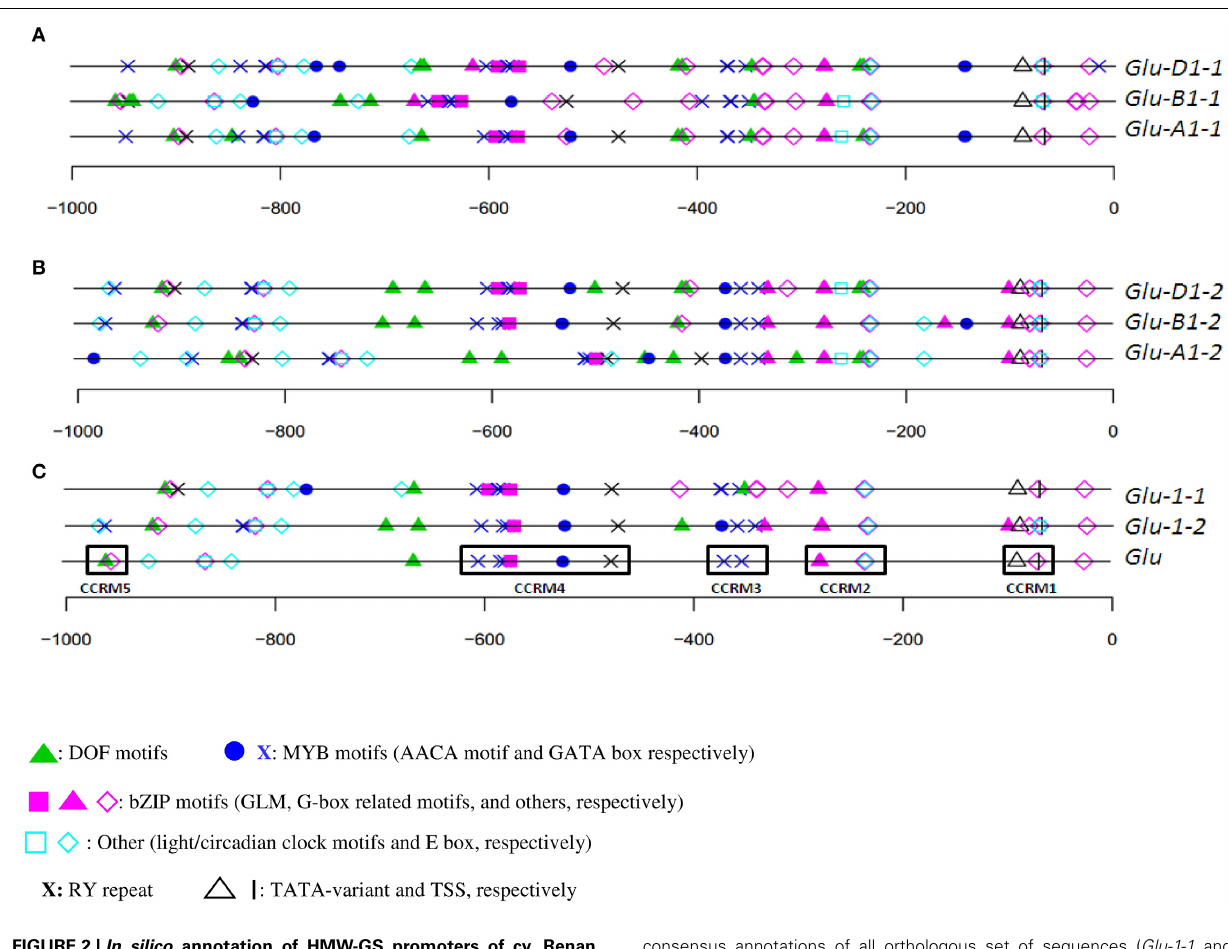
FIGURE 2 | In silico annotation of HMW-GS promoters of cv. Renan. Positions are indicated relatively to the start site. Sequences were obtained from public databases. (A) x-type Glu-A1-1 , -B1-1 , and -D1-1 homoeologs; (B) y-types Glu-A1-2 , -B1-2 , and -D1-2 homoeologs; and (C)